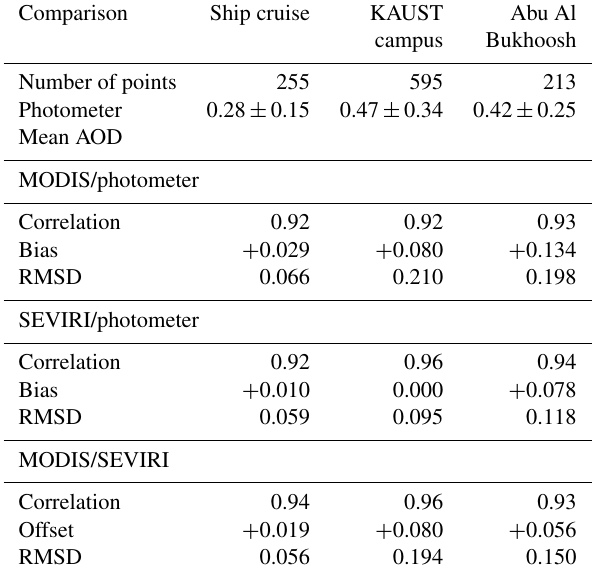
Table 1. Validation statistics between AODs at 630nm from ship cruise data and from AERONET at KAUST and at Abu Al Bukhoosh against SEVIRI and MODIS. Sunphotometer mean AODs include the associated standard deviations. Biases are satel- lite retrieval AOD – AERONET